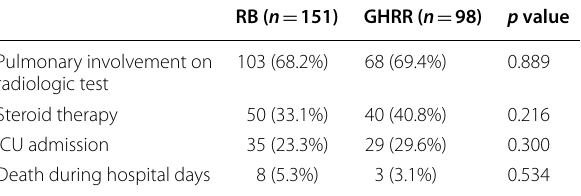
Table 3 Clinical